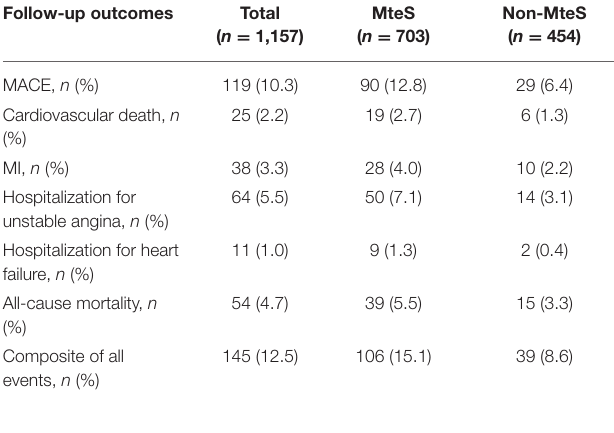
TABLE 3 | Subgroup analysis of the associations between MetS and MACE. Unadjusted analysis Adjusted analysis